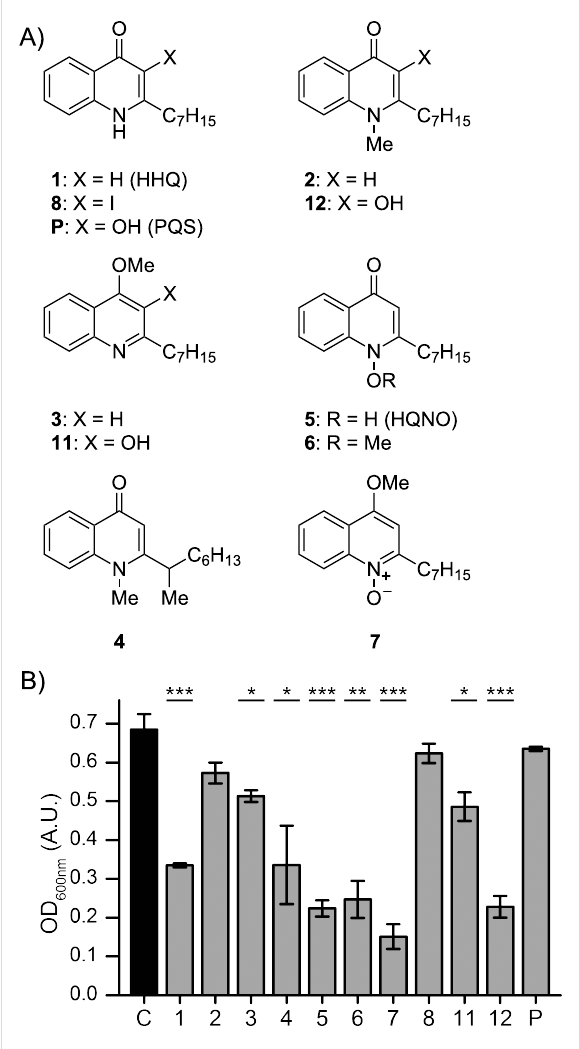
Figure 1: Overview of AQ compounds (A), and effect of AQs on the growth of S. aureus Newman (B). 24-Well plates were inoculated at an optical density (OD 600 nm ) of 0.1 and supplemented with 100 µM of the indicated AQs ( 1 – 12 ), PQS (P) or an equal amount of DMSO as the control (C). Black and grey bars show the mean optical density after 4 hours of cultivation at 37 °C of 3 biological replicates. Error bars represent the standard error. One-way ANOVA was used for statistical analysis, and significant differences compared to the control are indi- cated (* P < 0.05, ** P < 0.01, *** P < 0.001).